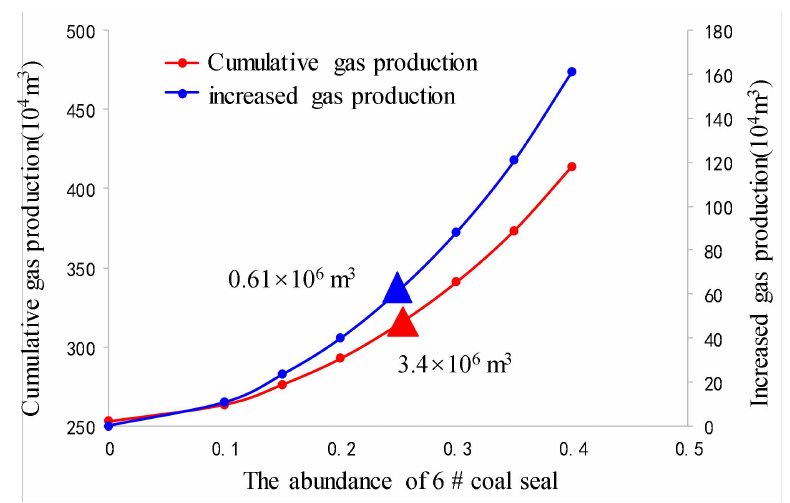
Figure4—Contribution of 6# coal under different reserve